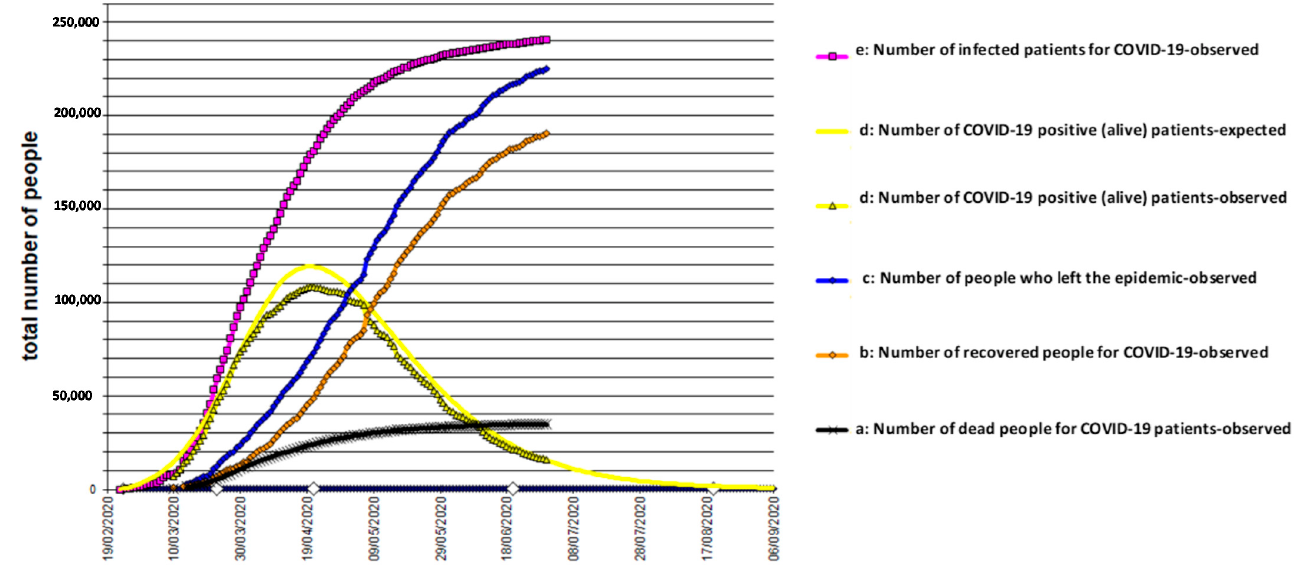
Figure 1. COVID-19 epidemic time-course in Italy.